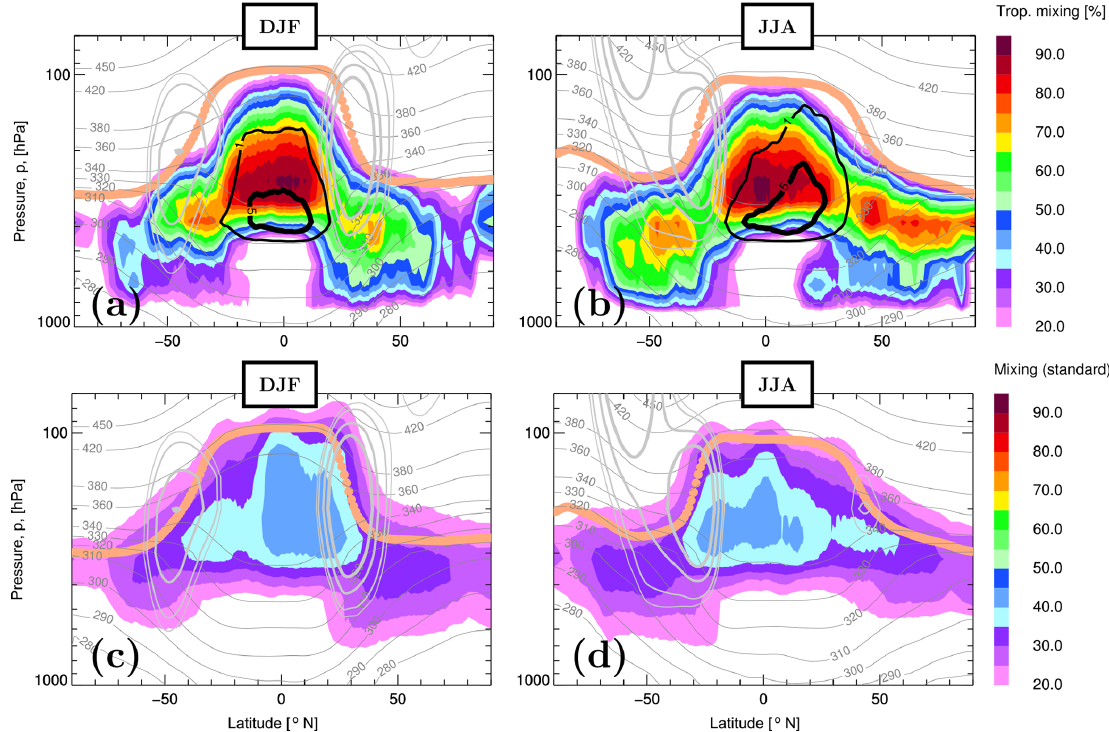
Figure 8. (a, b) DJF/JJA 1-year (2005) climatology of percentage of CLaMS air parcels undergoing tropospheric mixing (colors) and of air parcels lifted from the lowest layer of the model into the middle and upper (tropical) troposphere (black contours). (c, d) Same type of climatology but for air parcels which undergo the standard CLaMS mixing procedure (adaptive regridding driven by horizontal strain and vertical shear within the CLaMS layers). The respective WMO tropopause (beige), horizontal wind marking the position of the jets (light gray), and the isentropes (dark gray) are also